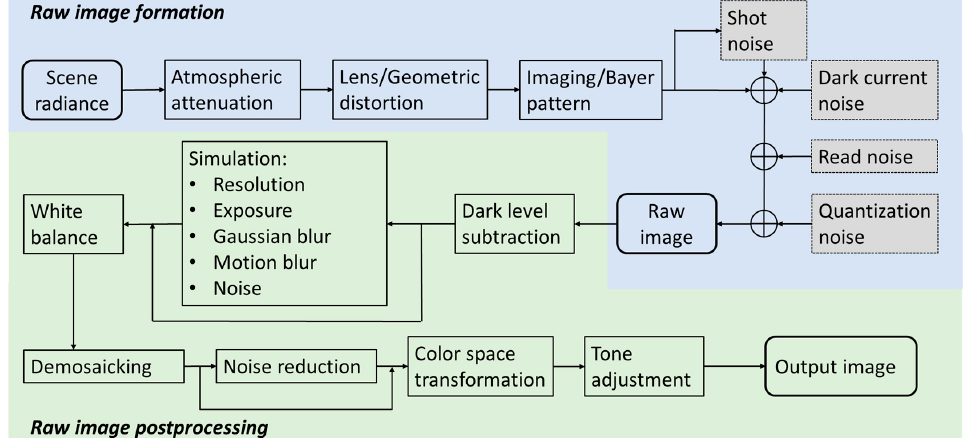
Figure 1. Raw image formation and postprocessing pipeline. Redrawn from Tsin et al. [22], Liu et al. [23], and Sumner [24] based on the noise model proposed by Healey and Kondepudy [25].